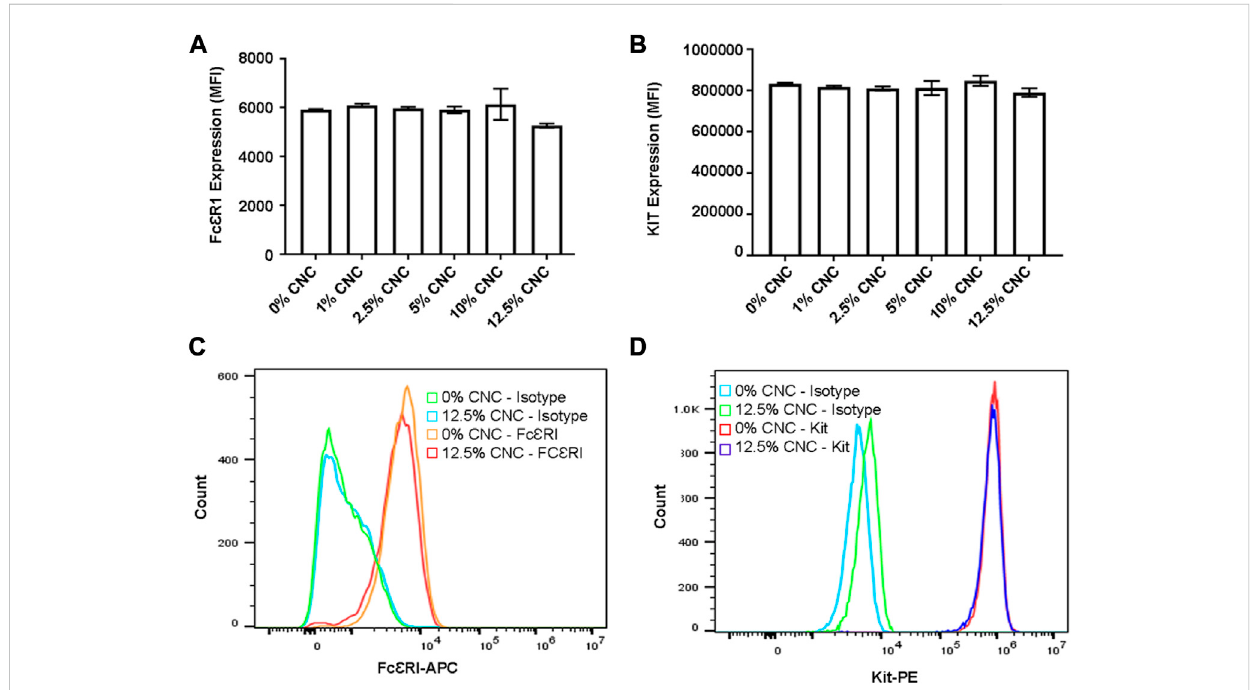
FIGURE 4 Flowcy-toinctricanalysisofFceRIandKit(0117)cellsurfacereceptorexpressionpostincubationonCNC/agarosesubstrates.BMMCswerecultured either intheabsence or presence ofCNC/agarosesubstrates (0% – 12.5%) for 18 hand analyzed for FecR1 and Kitreceptorexpression via fl owcytometry. GraphicalrepresentationofMFIsofuntreatedBMMCs(0%CNC)orBMMCincubatedwith12.5%CNC/agarosesubstrateslabeledwith (A) anti-FccRI-APC or (B) anti-KIT-PE antibodies. (C) Histogram overlay pro fi le of untreated BMMCs (0% CNC) or BMMC incubated with 12.5% CNC/agarose substrates and stained with anti-FccRI-APC antibody or its isotype control. (D) Histogram overlay pro fi le of BMMCs incubated either alone (0% CNC) or with